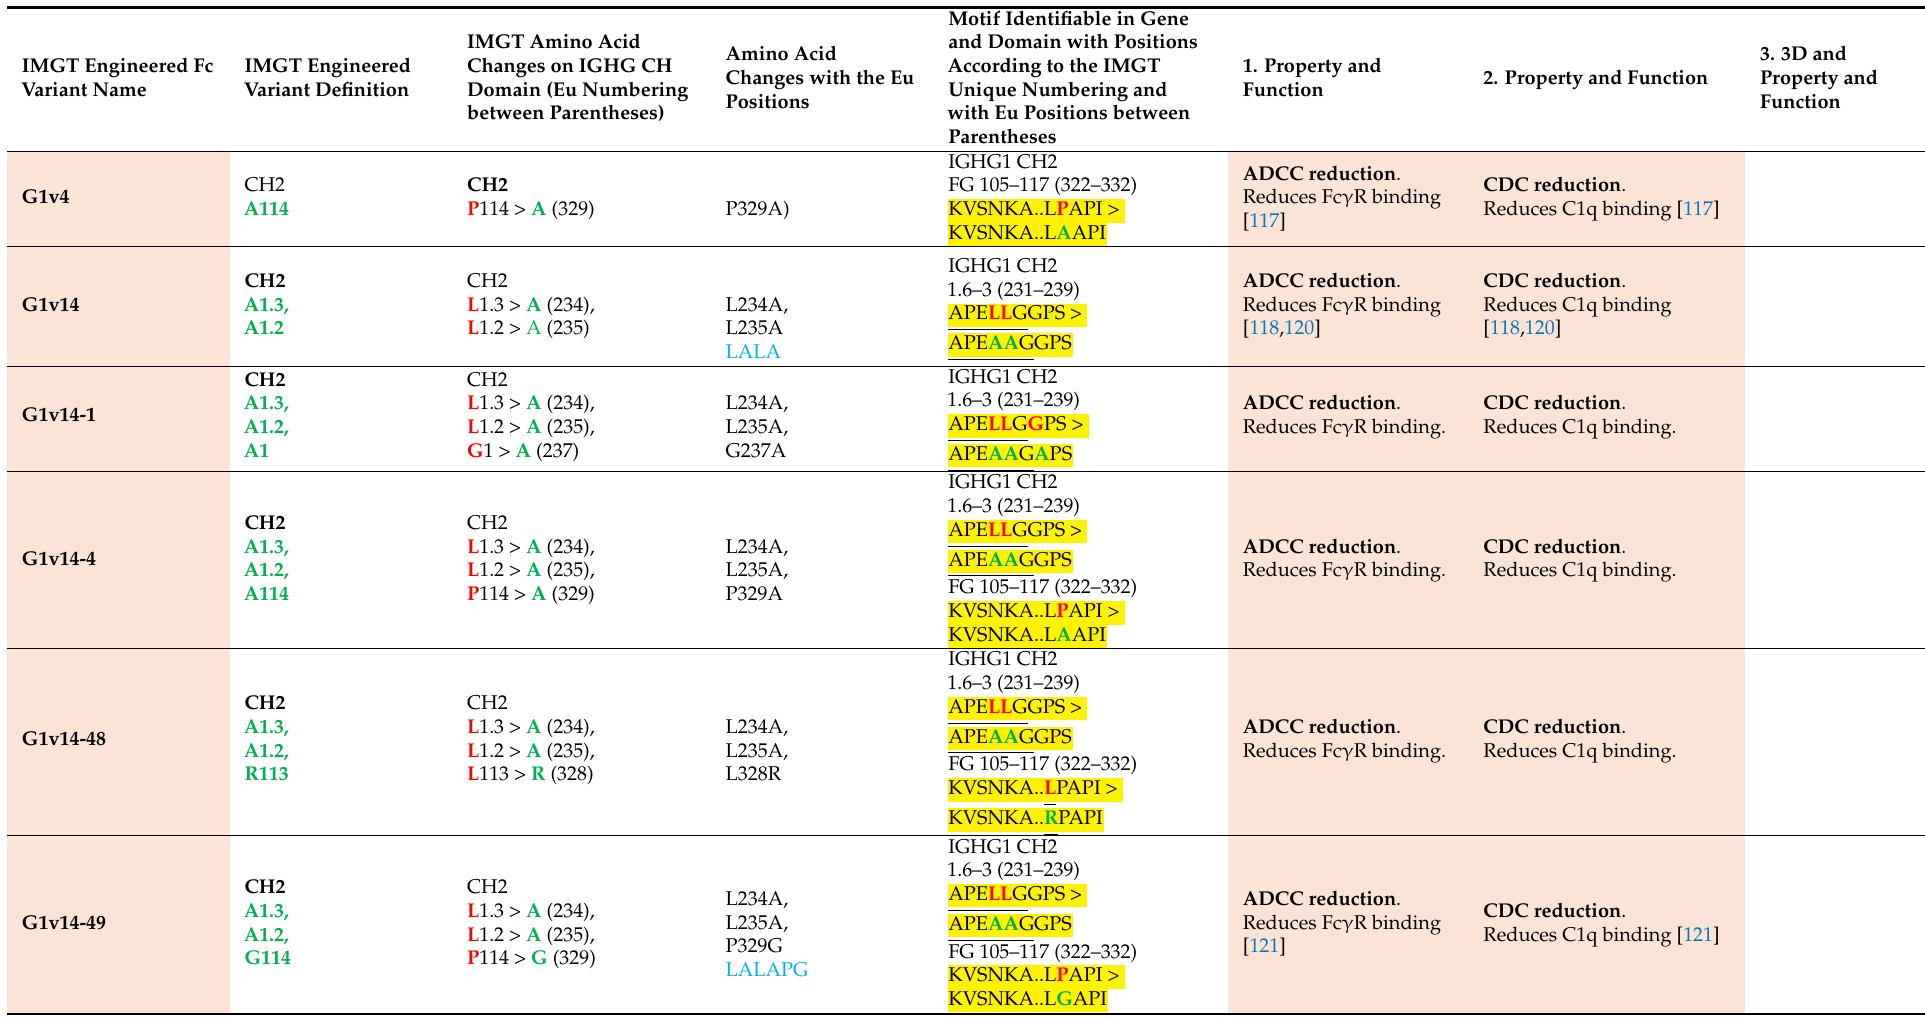
Table 10. IMGT nomenclature, Eu positions and IMGT motif of engineered Fc variants involved in antibody-dependent cellular cytotoxicity (ADCC) and complement-dependent cytotoxicity (CDC) reduction (Effector